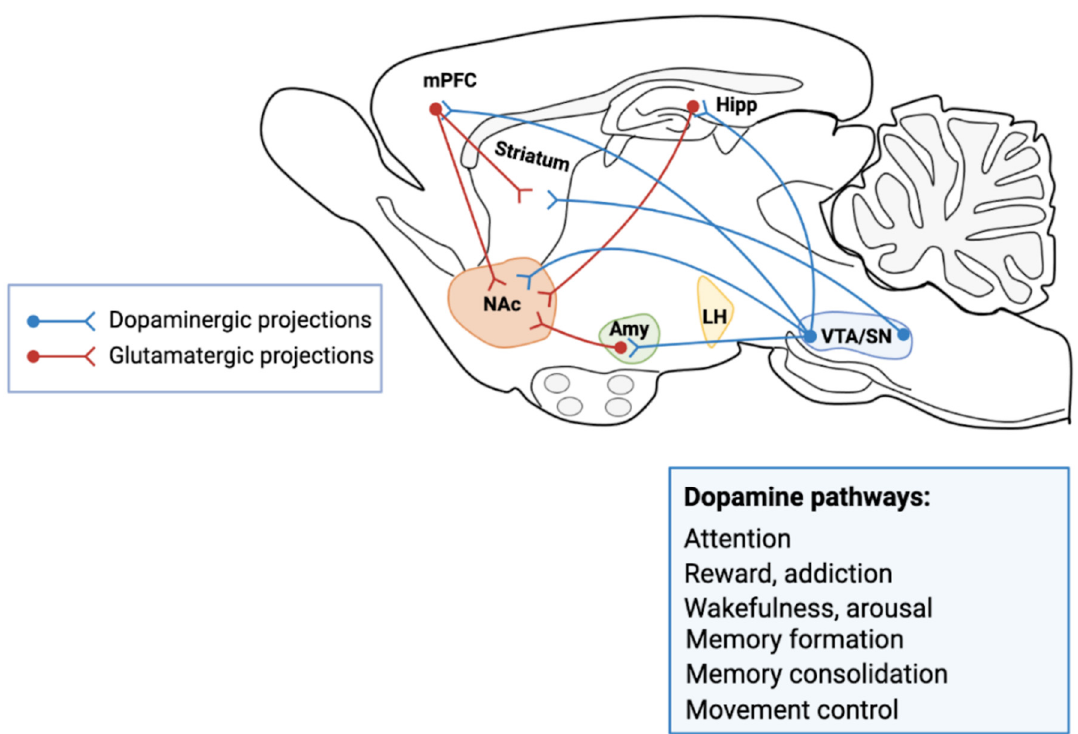
Figure 1. A simplified schematic of the major connections to and from the ventral tegmental area (VTA) and substantia nigra (SN) in the rodent brain. The primary reward circuit includes DAergic projections from the VTA to the nucleus accumbens (nAc), which release dopamine (DA) in response to reward-related stimuli. The nAc receives dense innervation from glutamatergic neurons from the medial prefrontal cortex (mPFC), hippocampus (Hipp) and amygdala (Amy), as well as other regions (Lateral Hypothalamus, LH). The caudate and putamen nuclei of striatum receive dense innervation from zona compacta of the SN and from PFC. The DAergic pathways control attention, addiction, reward, wakefulness, arousal, memory formation and memory consolidation. The illustration was prepared from scratch and created with our original design using Biorender.com.